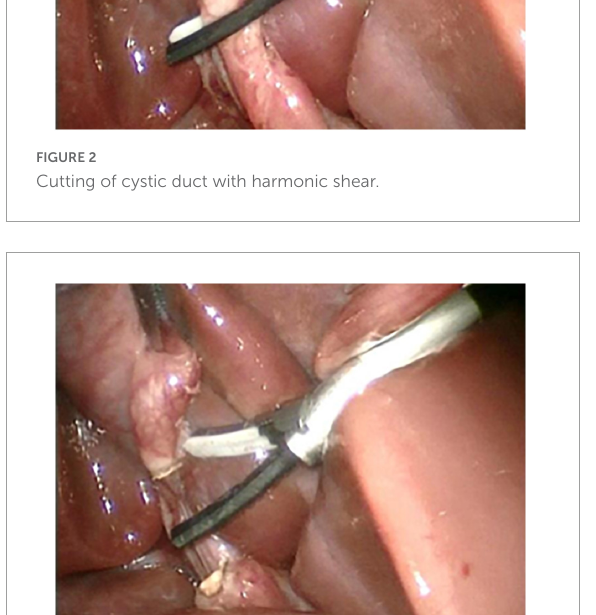
FIGURE3 Both ends of the cystic duct after being cut by harmonic shear.